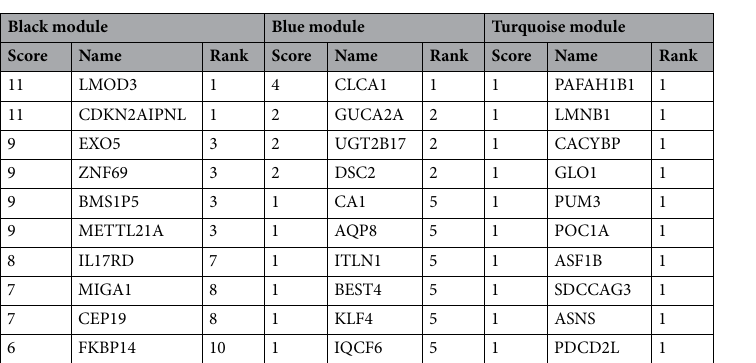
Table 3. Identified hub genes for each module along with their ranks, and